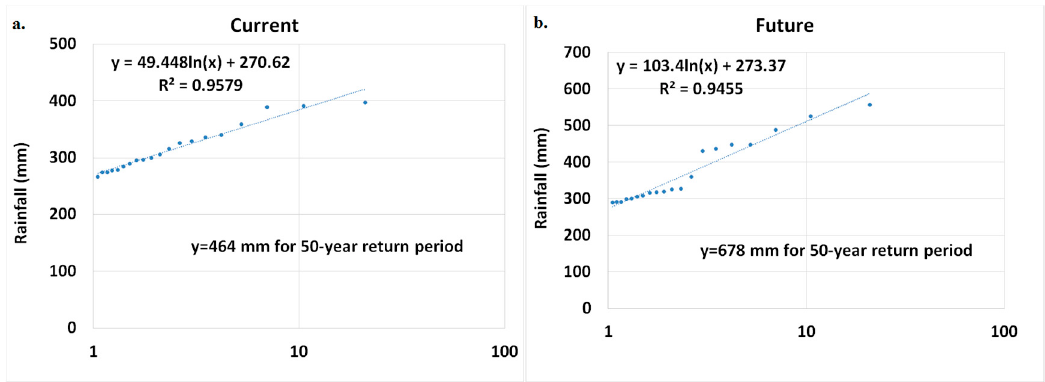
Figure 5. The calculation of the 50 ‐ year storm return period based on 3 ‐ day accumulated data for the ( a ) current; and ( b ) future projection.